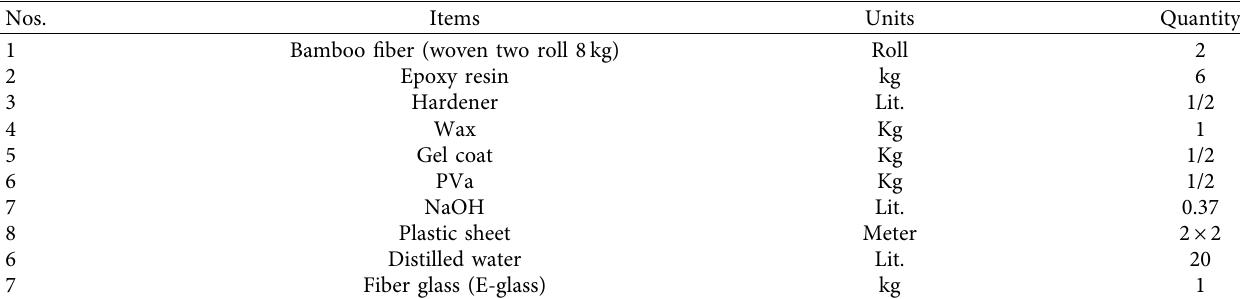
Table 1: Materials used.